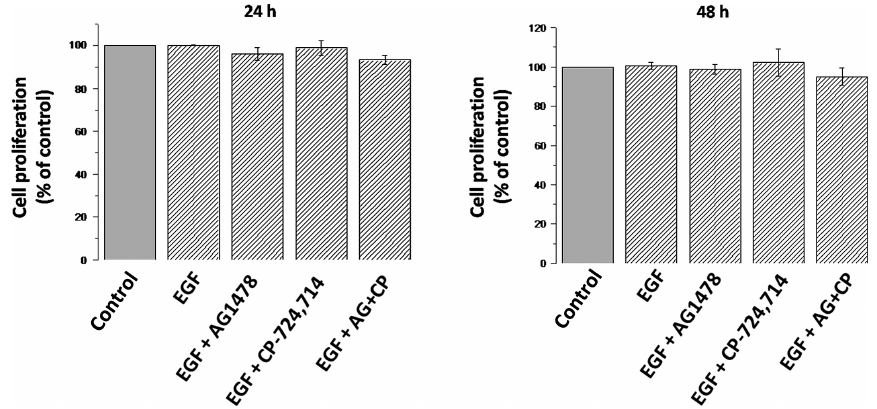
Figure 2. The effect of EGFR and/or HER2 inhibition on DLD-1 proliferation. Cells were incubated with AG1478 (1 μ M) and CP-724,714 (1 μ M) for 30 min, followed by the introduction of EGF (20 ng/mL). Cell proliferation was evaluated for 24 and 48 h. The results are expressed as mean ± SD of three separate experiments in triplicate.